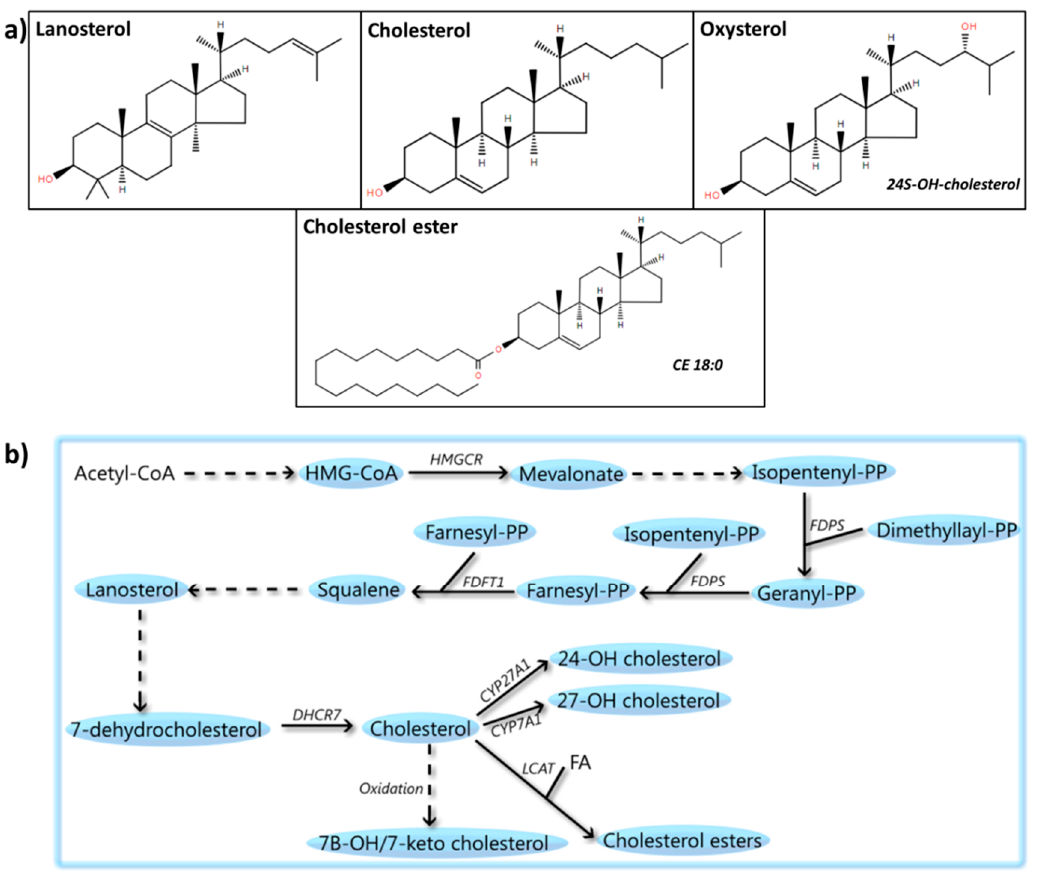
Figure 6. Sterols: structures and metabolic steps involved. ( a ) Schematic representation of the chemical structures of sterols, including lanosterol, cholesterol, oxysterols (24S-hydroxy-cholesterol), and cholesterol esters (CE 18:0). Chemical structures are adapted from the LIPID MAPS structure database [25]. ( b ) Schematic overview of steps involved in sterol metabolism. Acetyl-CoA is used to synthesize β -hydroxy β -methylglutaryl-CoA (HMG-CoA), which is converted into mevalonate by 3-hydroxy-3-methylglutaryl-coenzyme A reductase (HMGCR). Mevalonate is metabolized to isopentenyl-PP by a multistep process, followed by its conversion to geranyl-PP and farnesyl-PP by the enzyme farnesyl pyrophosphate synthase (FDPS). Two molecules of farnesyl-PP are condensed by squalene synthase (FDFT1) to create squalene, which is further metabolized to lanosterol and 7-dehydrocholesterol. Subsequently, cholesterol is synthesized from 7-hydrocholesterol by 7-dehydrocholesterol reductase (DHCR7). Finally, cholesterol can be oxidized to compounds such as 7-beta-hydroxycholesterol or 7-ketocholesterol. It can also be esterified to a fatty acid (FA) by phosphatidylcholine-sterol acyltransferase (LCAT) to create cholesterol esters or metabolized by the cytochrome p450 to produce compounds such as 24/27-hydroxycholesterol.